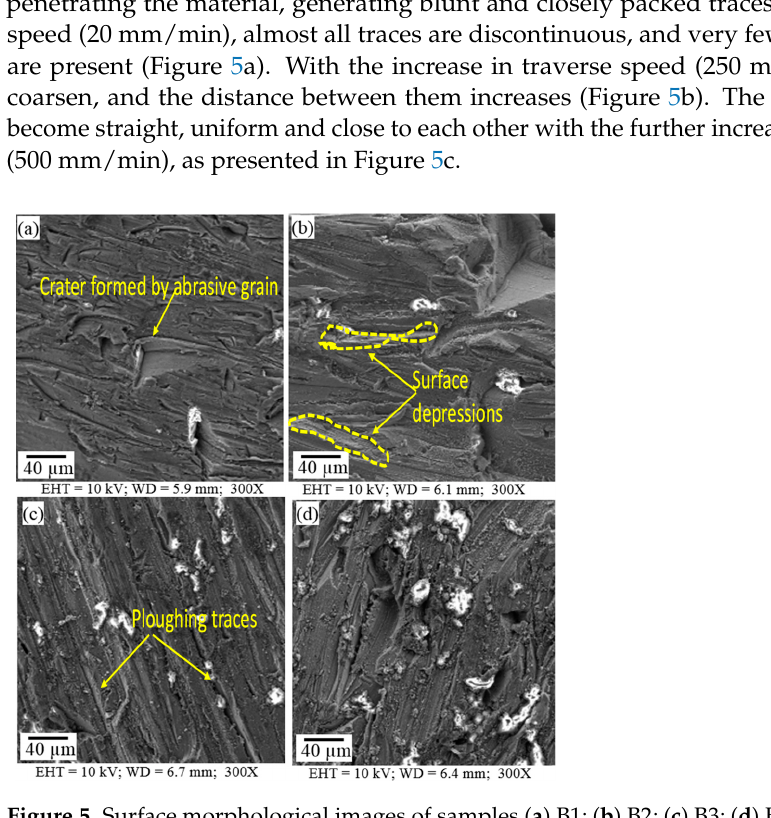
Al 2 O 3 reinforcement particles. This reinforcement concentration prevents the jet from